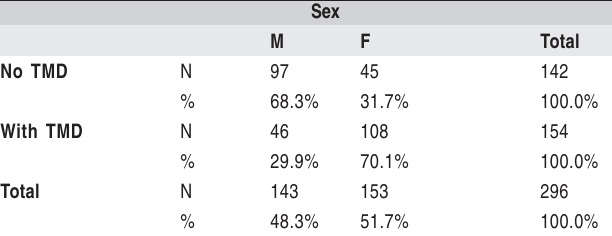
Table 1 . Distribution of the participants by sex and the presence of